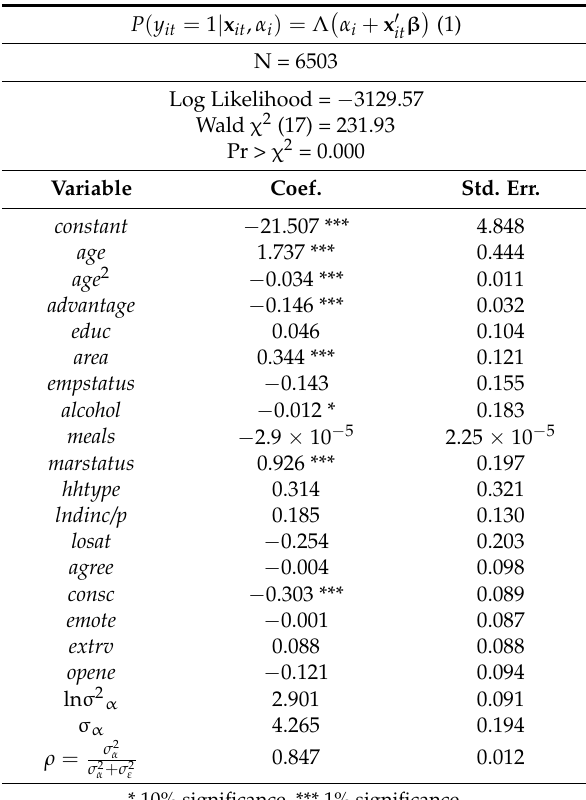
Table 6. Restricted Model, Coefficients and Standard